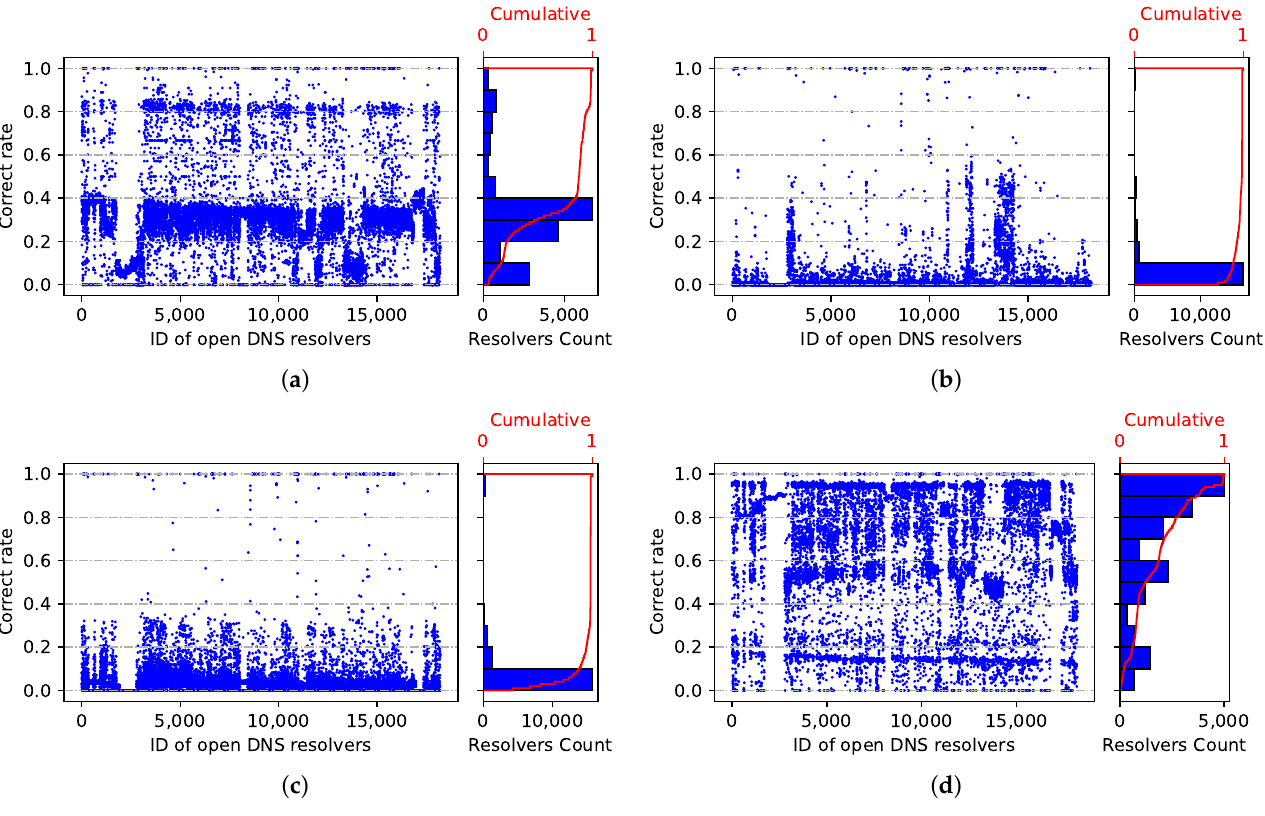
Figure 12. Distribution of correct rate of open DNS resolvers responding to four domains.